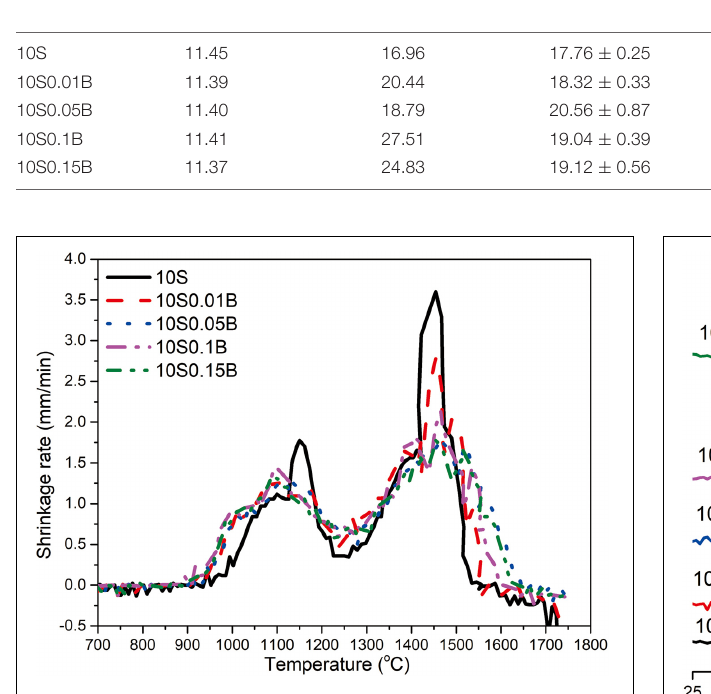
FIGURE 1 | Densification curves of the composite specimens.